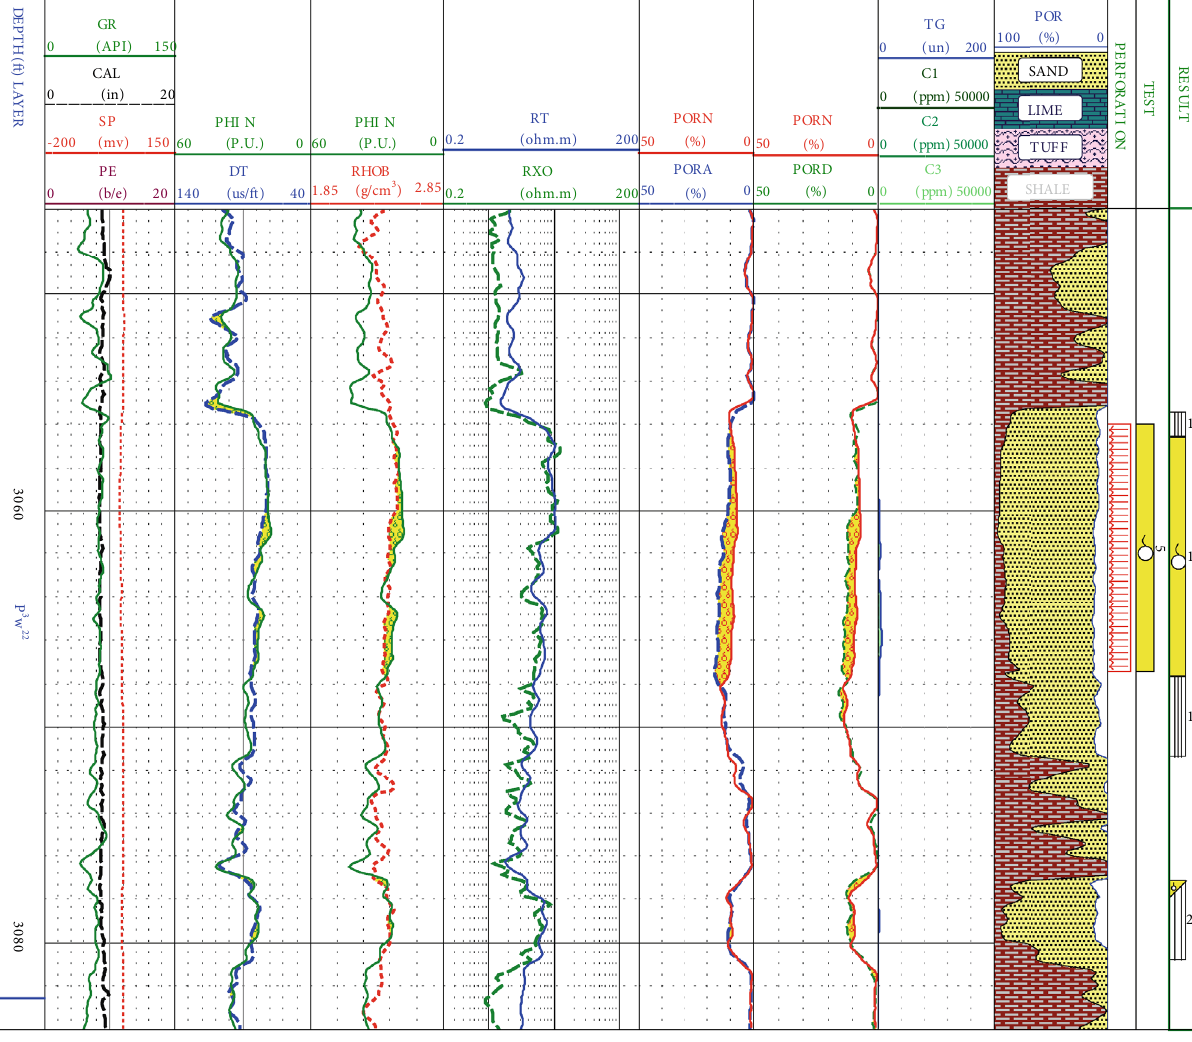
Figure 6: K58003 well logging interpretation